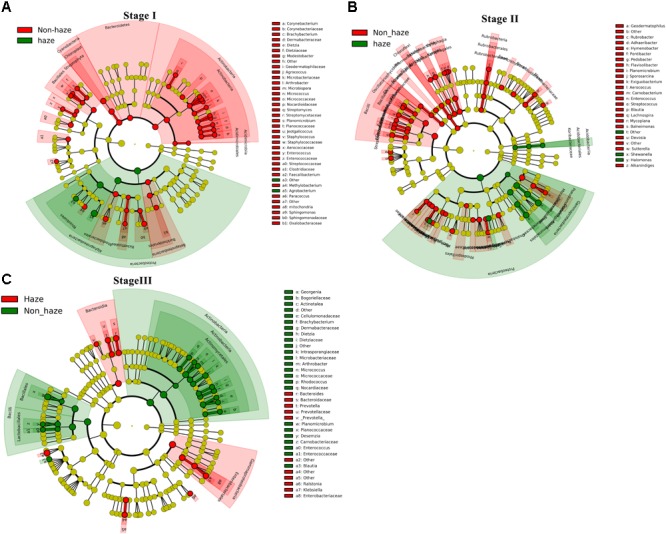
Discriminant genera between samples collected from the haze and non-haze days at Stage I (A), Stage II (B), and Stage III (C) estimated by LEfSe analysis based on the top 0.1% relative abundance in all samples. Red and green colors represent taxa with significant changes on the haze and non-haze days, respectively (yellow, not significant). The size of each circle is proportionate to the taxon’s relative abundance. Only taxa with an LDA score >2.0 are shown.